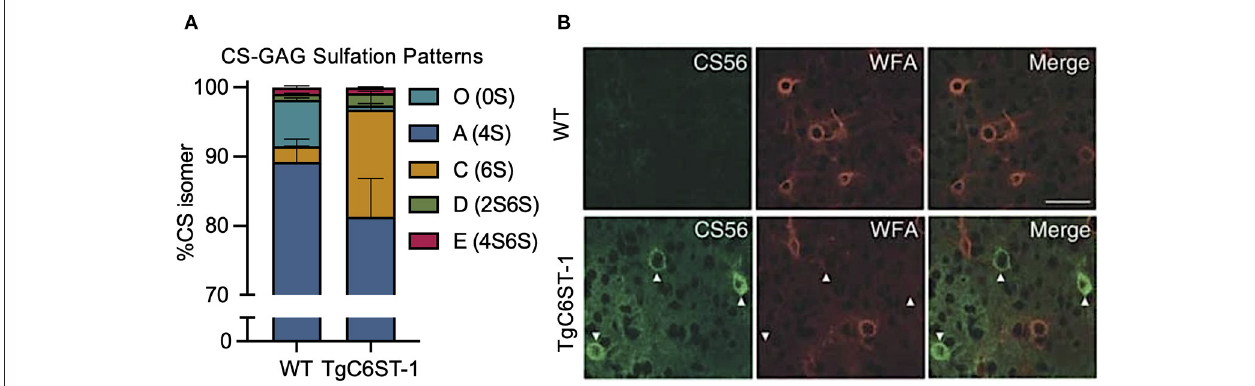
FIGURE 5 | Overexpression of the CS-C (6S) isomer alters PNN CS-GAG sulfation patterns and histochemical detection. TgC6ST-1 mice overexpressing the CS-C (6S) isomer exhibit (A) increased mono-sulfated CS-C (6S) and decreased non-sulfated CS-O (0S) isomer expression (see Miyata et al., 2012). (B) Histochemical labeling of brain PNNs shows decreased WFA + PNN structures in association with increased CS56 + PNN labeling in TgC6ST-1 mice compared to controls. Scale: 50 µ m (see Miyata et al., 2012). CS-GAGs, chondroitin sulfate-glycosaminoglycans; WFA, Wisteria floribunda